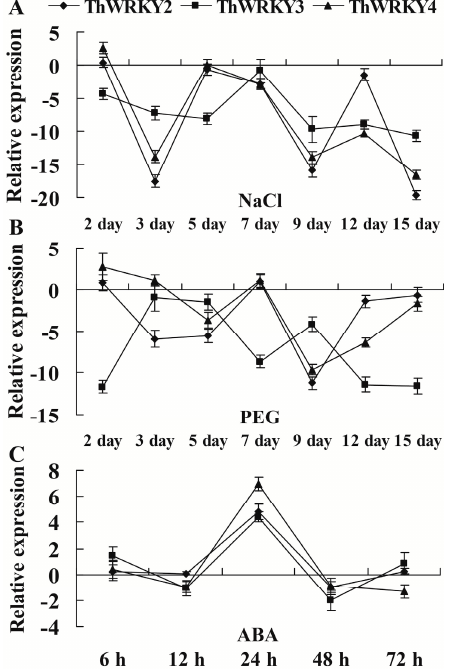
Figure 4. Expression profiles of ThWRKY2, ThWRKY3 and ThWRKY4 under different abiotic stresses. Uniformly developed 6-month-old T. hispida seedlings were treated with 300 mM NaCl ( A ), 15% ( w / v ) PEG6000 ( B ) or 100 μ M ABA ( C ) for the indicated times. A fresh water-only control was conducted in parallel. After these treatments, the roots of seedlings from each sample were harvested and pooled for real-time RT-PCR analyses. The error bars were standard deviations, which were calculated from multiple replicates of real-time PCR.